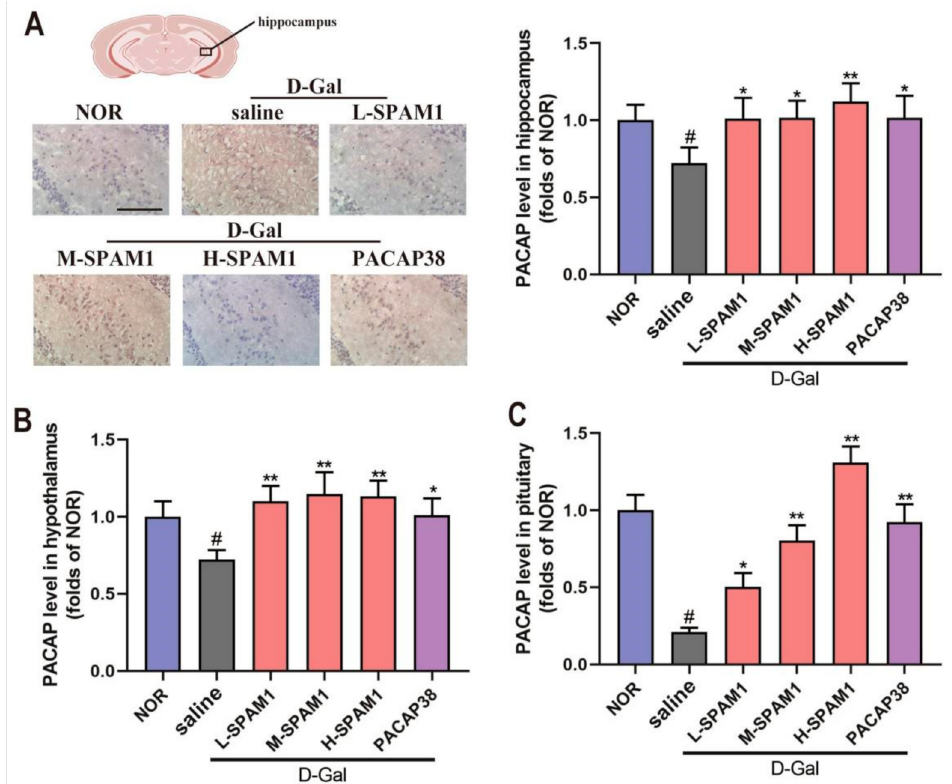
Figure 7. Effect of SPAM1 and PACAP38 on the levels of PACAP in hippocampus and pituitary of D- Gal-treated mice treated with L-SMAP1 (10 µ mol/kg/day), M-SMAP1 (40 µ mol/kg/day, H-SMAP1 (100 µ mol/kg/day), and PACAP3 (100 nmol/kg/day), respectively. ( A ) The immunohistochemical image ( left ) and corresponding quantitative measurement of staining intensity of PACAP ( right ) in hypothalamus; ( B ) the PACAP level in hippocampus tested by Elisa assay; ( C ) the PACAP level in pituitary tested by Elisa assay. As shown, SPAM1 and PACAP38 treatment significantly increase the levels of PACAP in both hippocampus and pituitary compared with the D-Gal group, while SPAM1 worked in dose-dependent manner. #, p < 0.05, D-Gal group vs. control group (NOR); *, p < 0.05, vs. D-Gal group; **, p < 0.01, vs. D-Gal group. Data are presented as the mean ± SE, n ≥ 6 (Scale bars: 100 µ